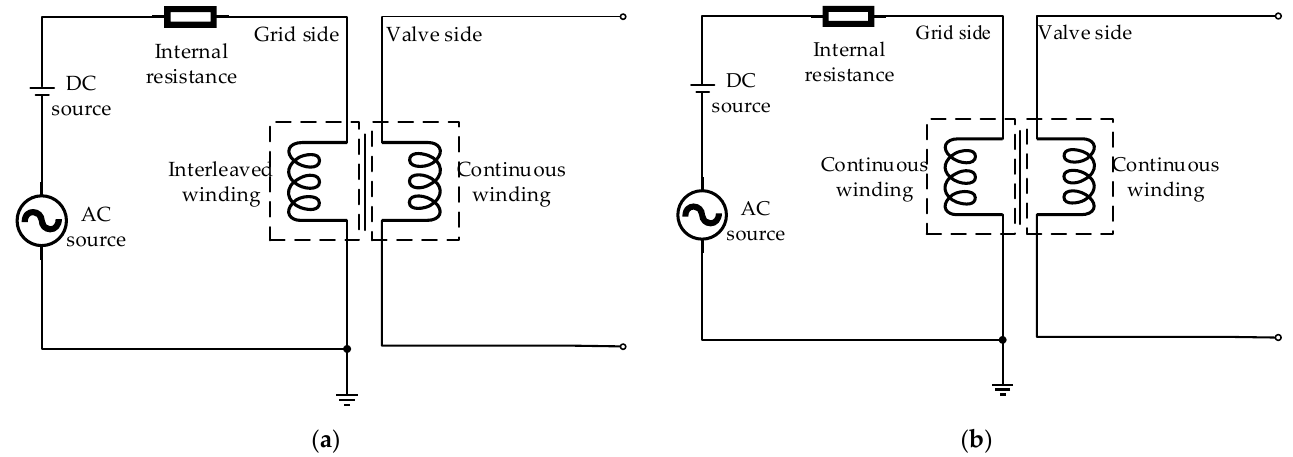
Figure 7. Coupling circuit structure under DC bias. ( a ) Interleaved windings; ( b ) Continuous windings. In the muti-physics field calculation of HFT, the FEM adopts sequential coupling method to calculate the vibration of HFT. The multi-physics field coupling simulation process is shown in Figure 8.